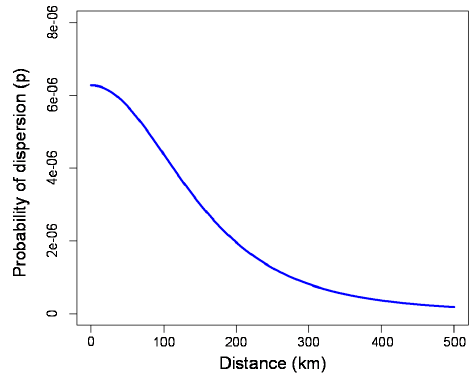
Figure 3. Dispersal kernel used to parameterize the kernel models after calibration ( ρ = 3 and u = 130). The model that best represented the known spread of T. erytreae was the kernel model with two entry points (Figure 4), accurately covering the northernmost areas of Galicia (Spain) after five years (Figure 4d). With the same combination of parameters, the kernel model with two entry points gave 50.46% of niche invaded (see Figure 5 and Table S6 online).